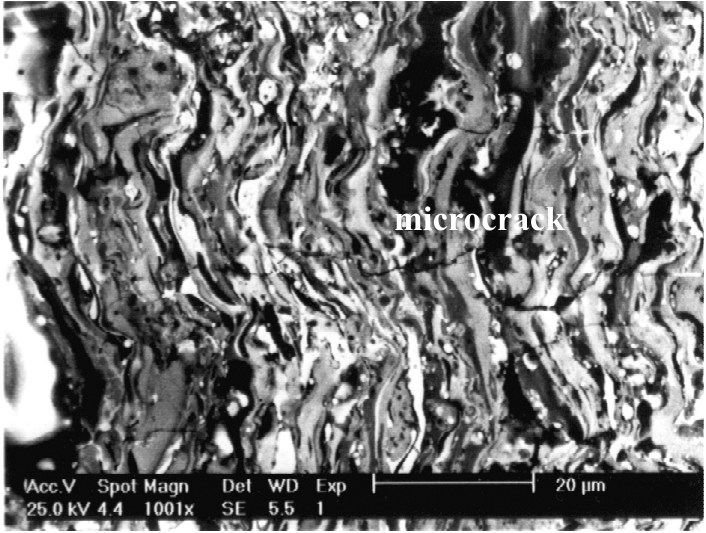
Figure 6. Microstructure on the cross section of the D-gun sprayed Fe-Al type coating the coating)